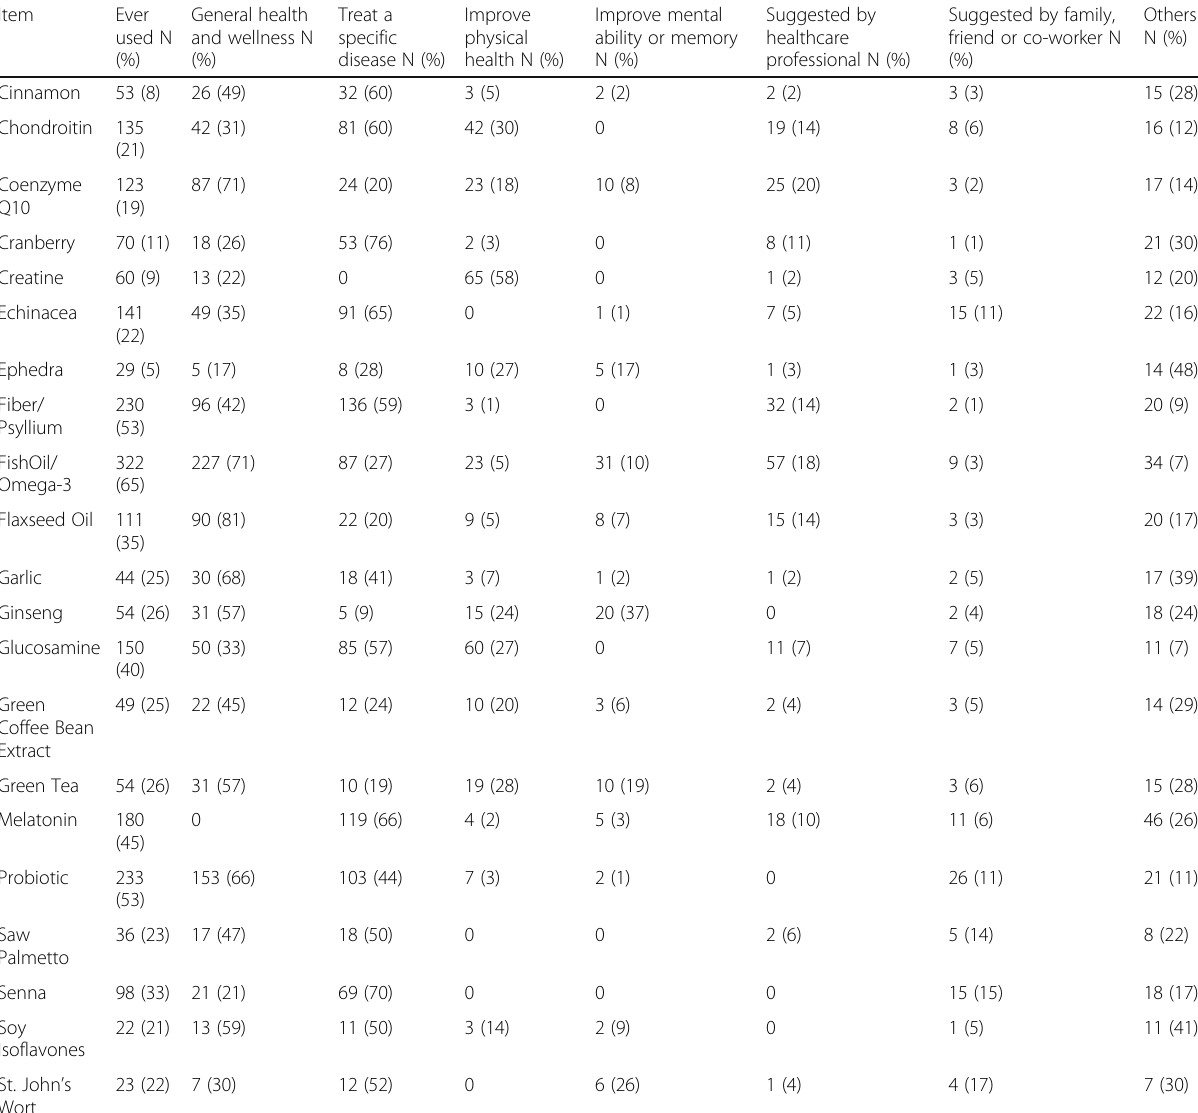
Table 3 Pharmacists ’ self-reported reasons for using herbal and other dietary